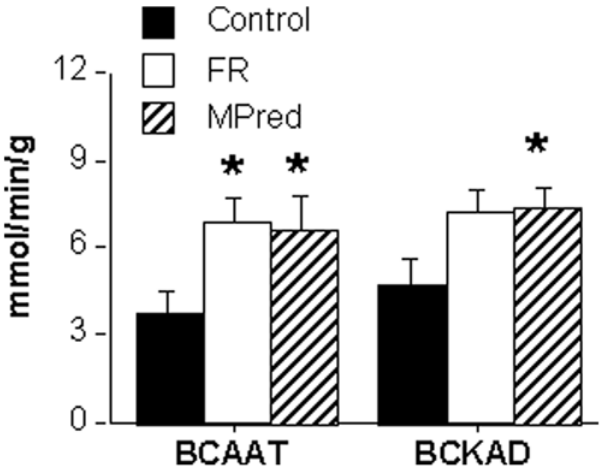
Figure 3. Activity of branched-chain amino acid aminotrans- ferase (BCAAT) and a -keto acid dehydrogenase (BCKAD) in skeletal muscle. Data from red quadriceps muscle (N=5–8 animals per treatment, mean 6 SEM). FR, food restricted; MPred, methylprednis- olone. * MPred and FR higher than Control, P , 0.05. There was a trend for higher BCKAD in FR versus Control, P = 0.052 .